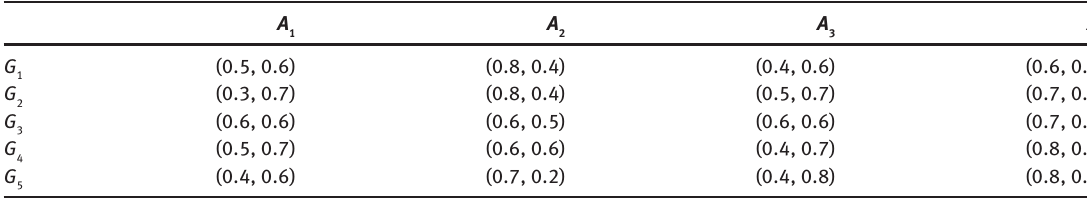
Table 6: Normalized Decision Matrix R 2 .